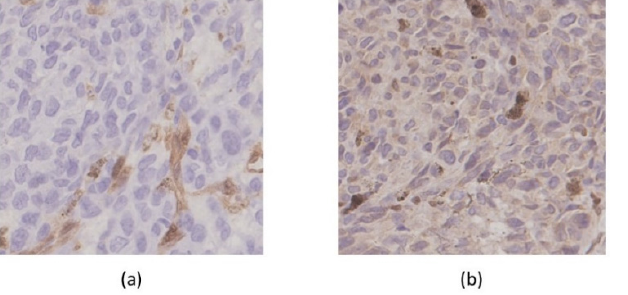
Figure 6. Immunohistochemical findings. Malignant melanoma was negative for PTEN ( a : 20 × ) and RB1( b : 20 × ).